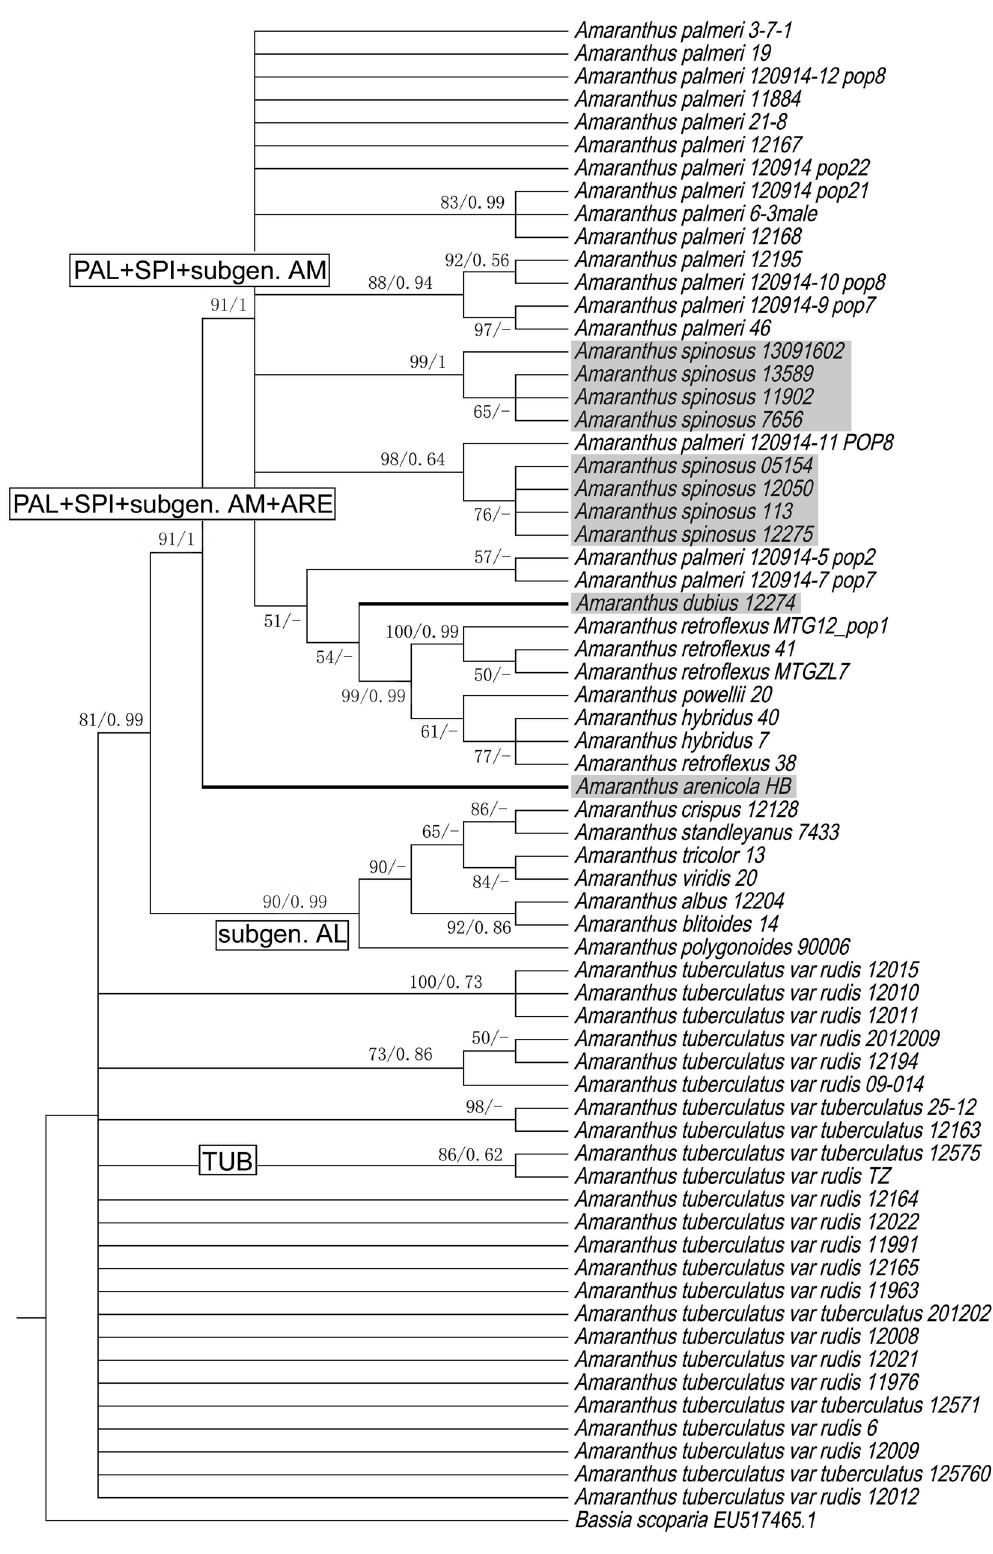
Figure 2. Maximum likelihood gene trees based on two regions within ALS. Amaranthus clades are delimited with grey highlight indicating anomalous samples (see text). Values at each node indicate maximum likelihood bootstrap support (BS)/Bayesian inference posterior probability (PP) value. The branches of A. albus , A. blitoides , A. blitum , A. palmeri , A. spinosus and parts of A. tuberculatus were